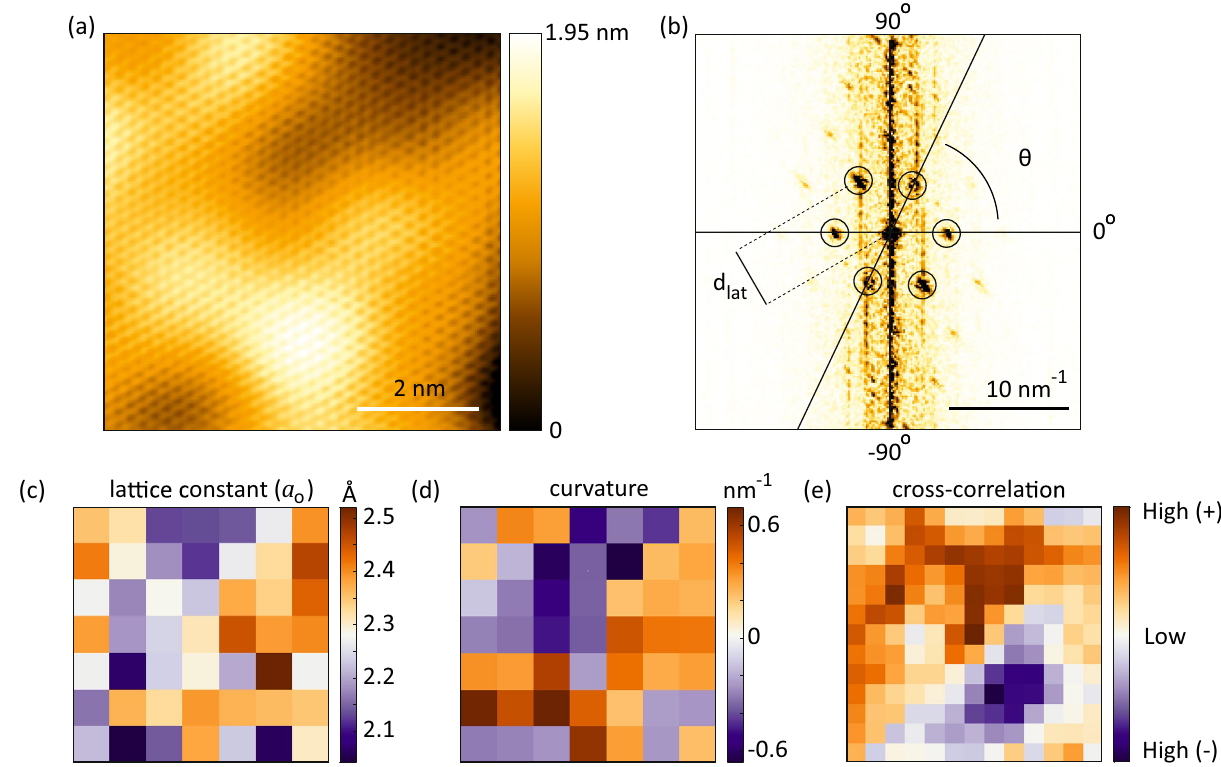
Figure 6. ( a ) Atomic-resolution image of graphene in the relaxed case and ( b ) its fast-Fourier transformation converted image with six clear lattice points. ( c – e ) The map of local average graphene lattice constant ( a 0 ) and local curvature calculated from ( a ) and their